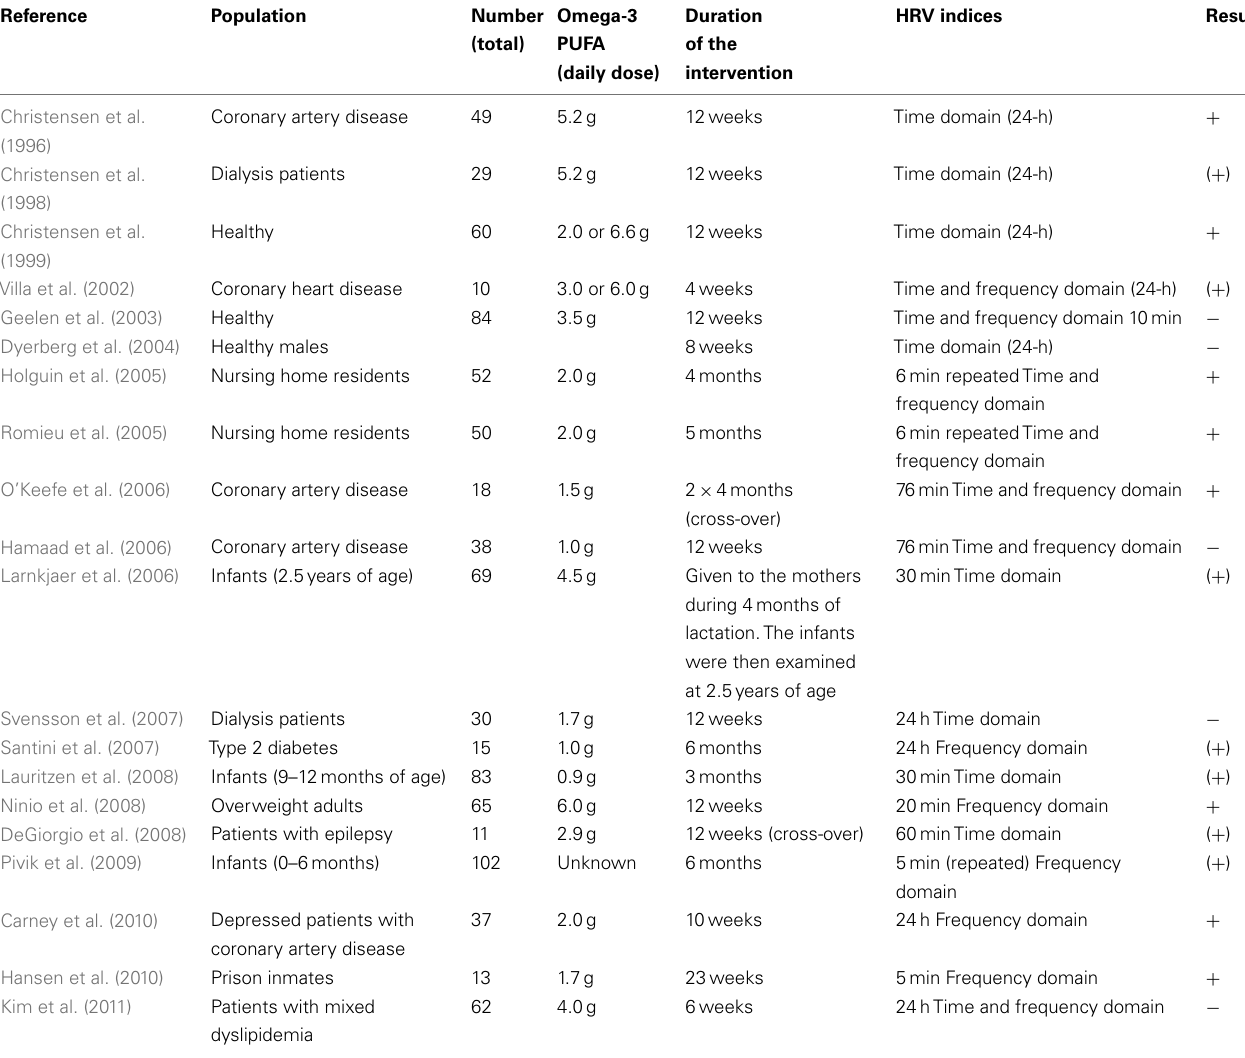
Table 2 | Interventional studies in humans with omega-3 PUFA and heart rate variability